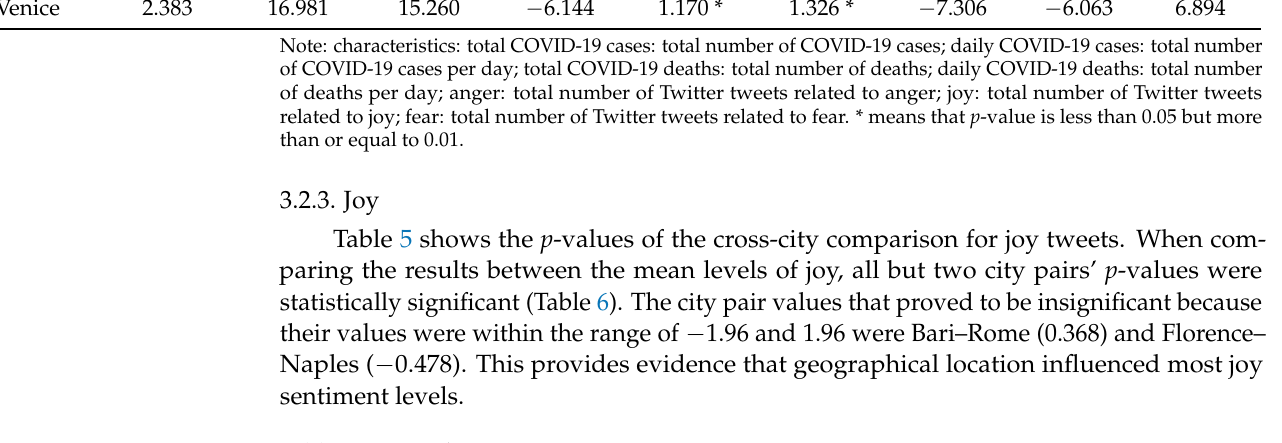
Table 5. Joy p -values.